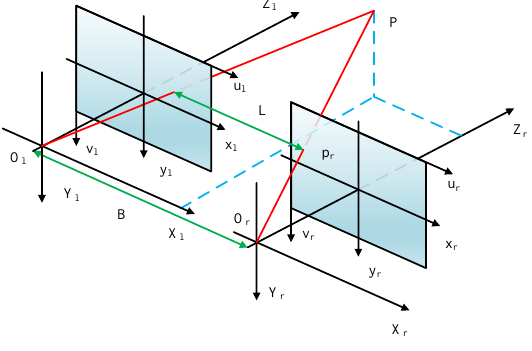
Figure 12. Principle of binocular stereo vision.